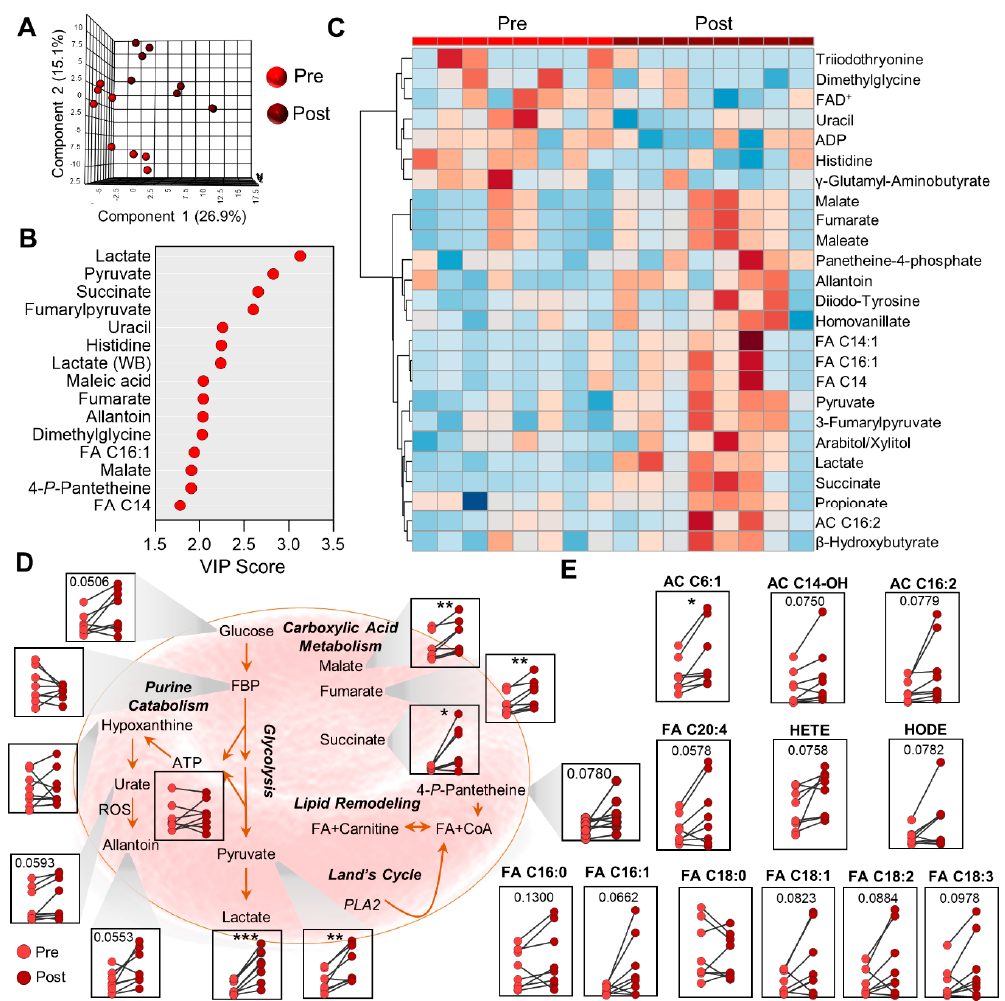
Figure 4. Red blood cell metabolomics. ( A ) Partial least-squares discriminant analysis (PLS-DA) of the RBC fraction isolated from cyclists before (Pre) and after (Post) a 30 min cycling test. ( B ) The top 15 metabolites ranked by variable importance in projection (VIP) of the PLS-DA are plotted. ( C ) Hierarchical clustering analysis showing the top 25 significant metabolites by t -test. ( D ) Symbol-and-line plots for glycolysis, purine catabolism, and carboxylic acid metabolism are shown. ( E ) The relative abundances of acylcarnitines (AC) and free fatty acids (FA) are shown. The y -axis values are in arbitrary units and not shown. The values from a paired, two-tailed Student’s t -test are shown (* p < 0.05, ** p < 0.01, *** p < 0.001).